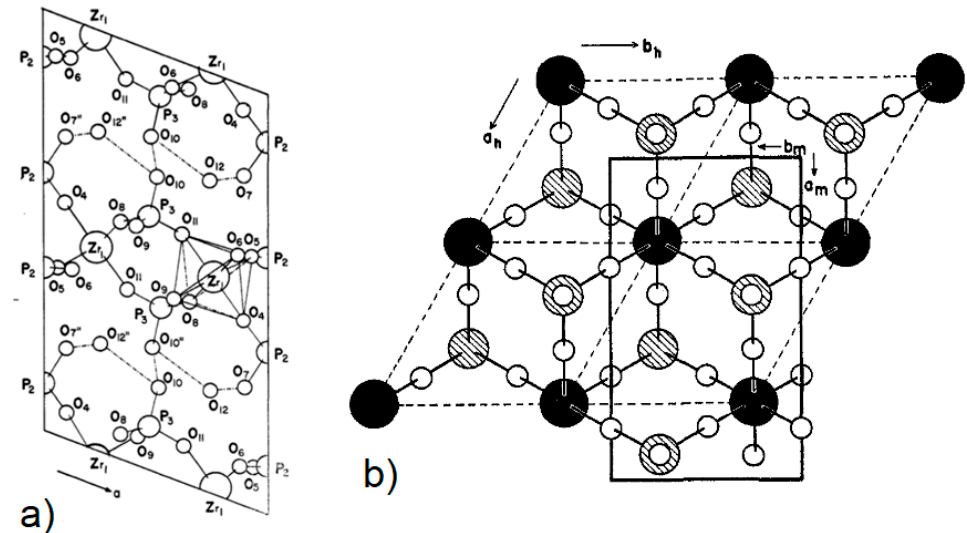
Figure 1. Crystal structure of α -ZrP viewed along the b -axis ( a ) and perpendicular to the layer ( b ). Adapted with permission from reference. [15]. Copyright 1969, American Chemical Society.